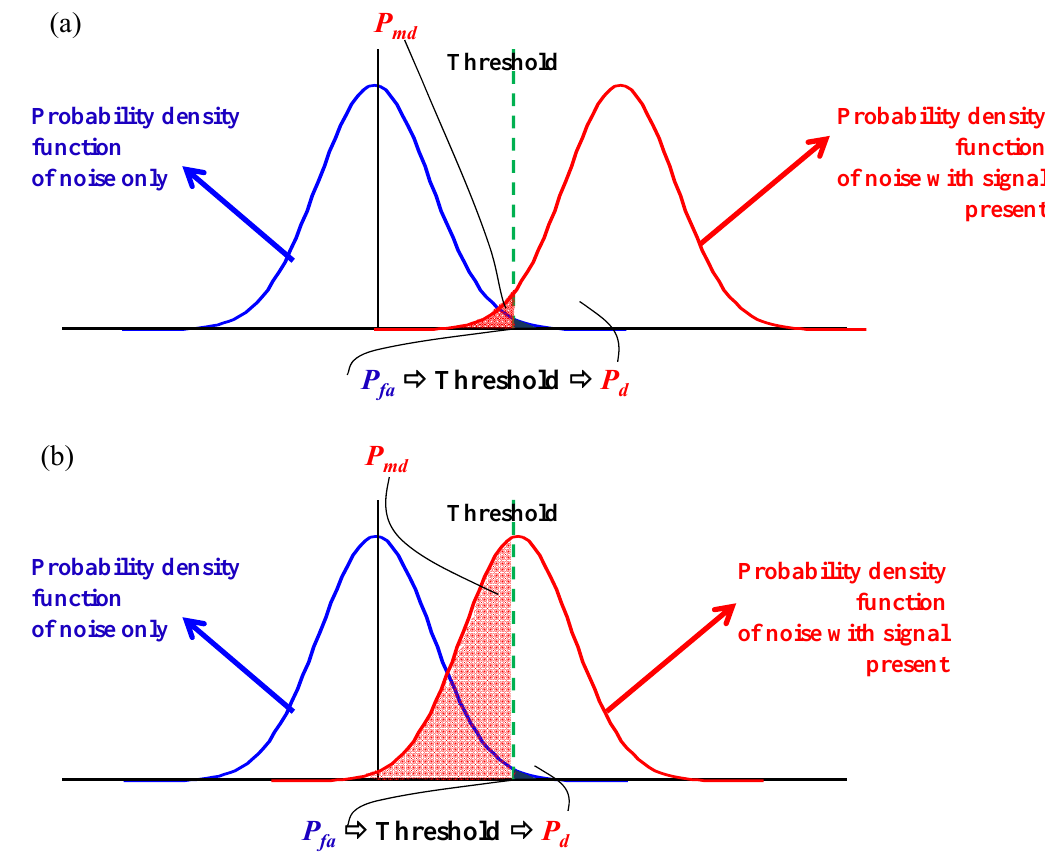
Figure 4. (a) The concept of typical strength GPS signal detection in acquisition process. (b) The concept of low received power GPS signal detection in acquisition